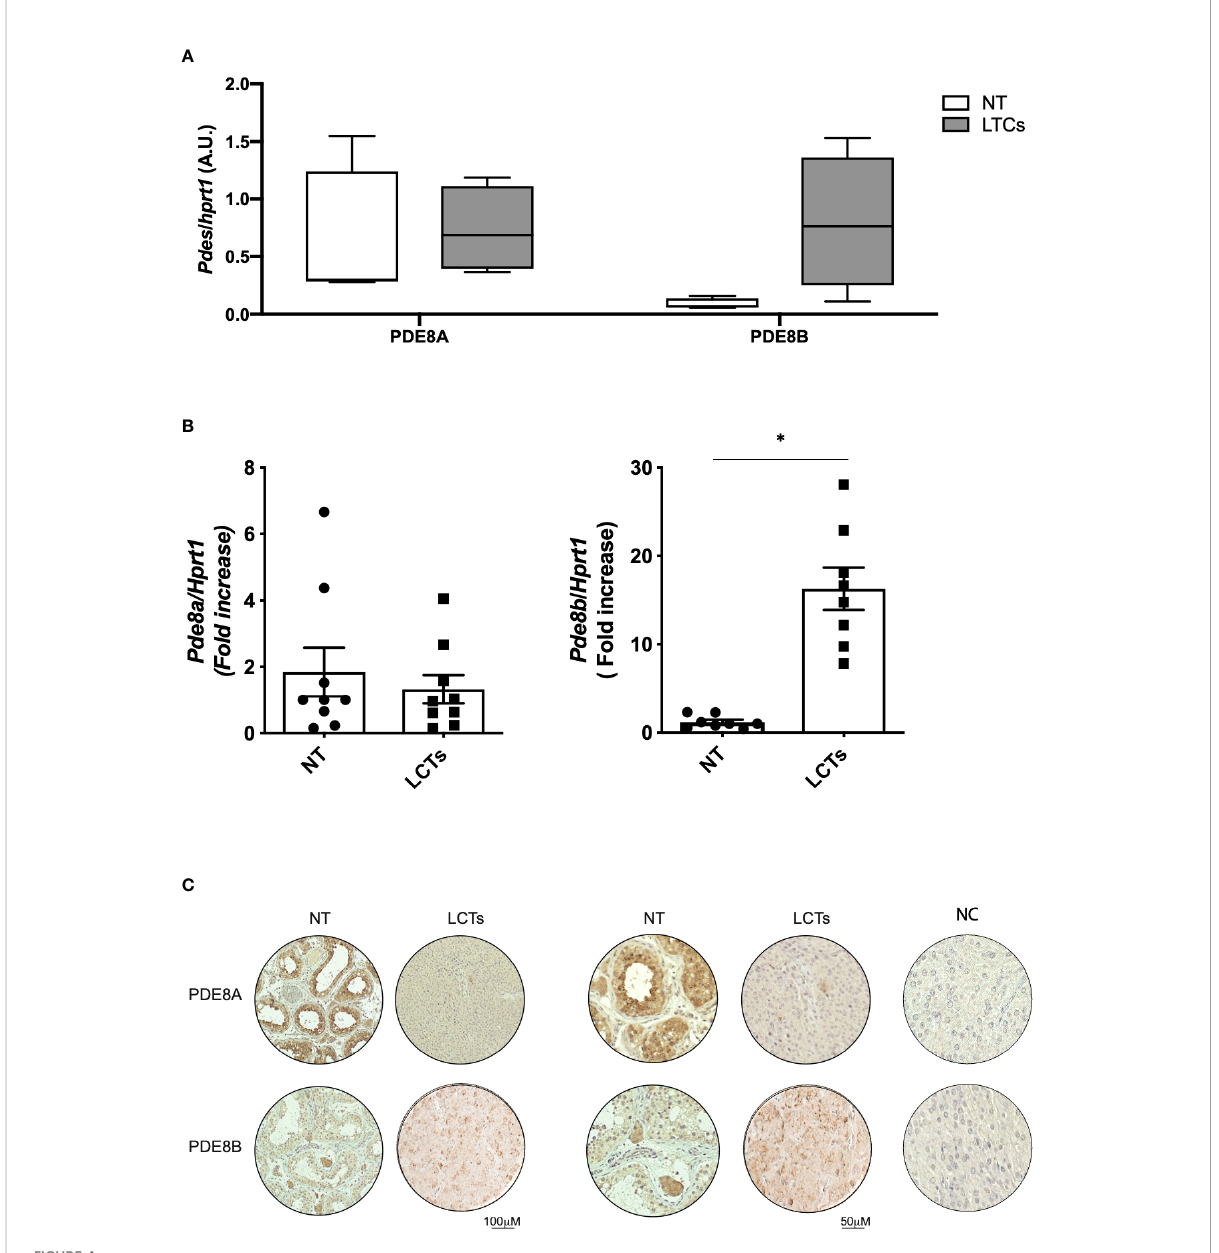
FIGURE 4 PDE8 expression analysis in LCTs (A) PDE8A and PDE8B mRNA expression analysis by QuantiGene Bioplex Assay on human testis biopsies from healthy subjects (NT) and LCT patients. Results, normalized for HPRT1, are expressed as arbitrary units (A.U, (median and 5-95 percentile) and reported in the histogram bar chart (n=4). (B) PDE8 isoforms mRNA expression analysis by qPCR, normalized for HPRT1, on human testis biopsies from healthy subjects (NT) and LCT patients. Results are reported as fold increase vs NT (mean ± SEM, n=9) in the histogram bar chart. *p<0.05. (C) PDE8 isoforms expression analysis by immunohistochemistry using commercially available anti-PDE8A and PDE8B antibodies on normal testis biopses (NT) and LCTs. Negative control (NC) is represented in the right panels. Scale bar are depicted beneath the